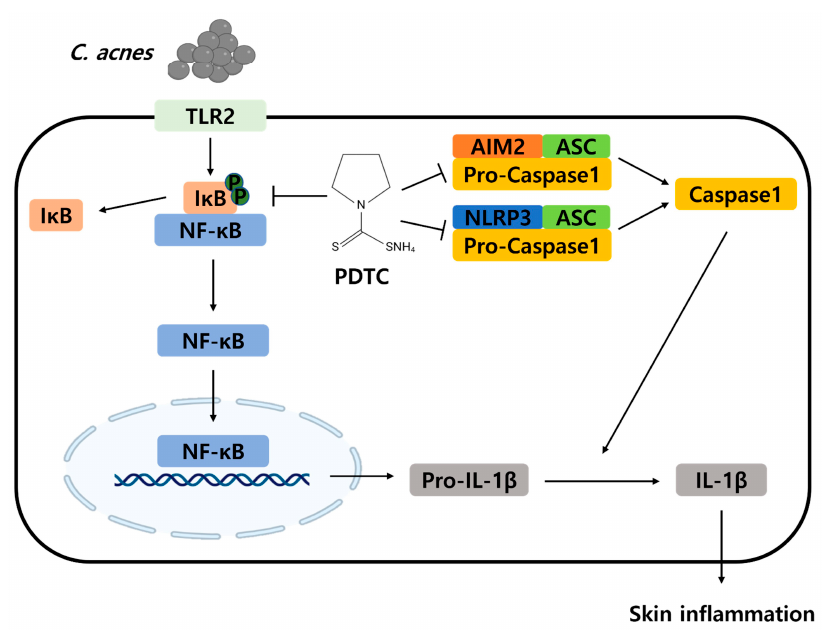
Figure 6. A schematic model of PDTC in the inhibition of C. acnes -induced skin inflammation. PDTC inhibits the secretion of IL-1 β by inhibiting C. acnes -triggered NF- κ B activation and inflammasome activation.